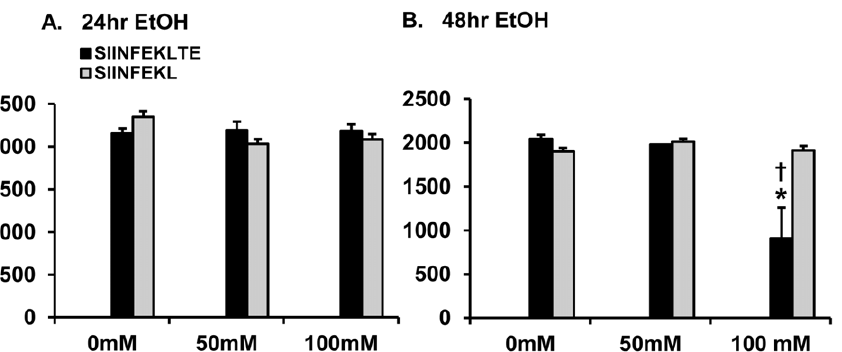
Figure 5. Antigen presentation of C-terminal extended SIINFEKLTE is suppressed in ethanol-treated murine primary peritoneal macrophages. Experimental setup is the same as detailed in Fig. 4A, except that instead of full length OVA the C-terminal extended SIINTEKLTE peptide was used. A. CD8 + T cell-derived IL-2 levels from 24 h EtOH-treated peritoneal macrophage groups is shown. B. CD8 + T cell-derived IL-2 levels from 48 h EtOH-treated macrophage groups is shown. Data plotted is mean levels of cytokine IL-2 (pg/ml) 6 SEM (three replicates per experiment) and is representative of three independent experiments. **p , 0.05 vs. control and 50 mM EtOH at respective time point.